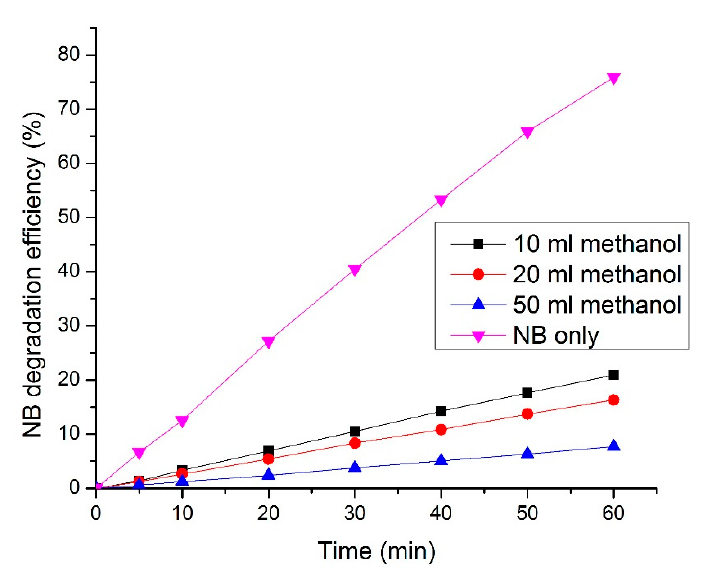
Figure 9. The effect of the addition of different methanol concentrations of NB degradation at an NB concentration of 20 mg/L, an oxygen flow rate of 3 L/min, and an applied voltage of 1.8 kV.